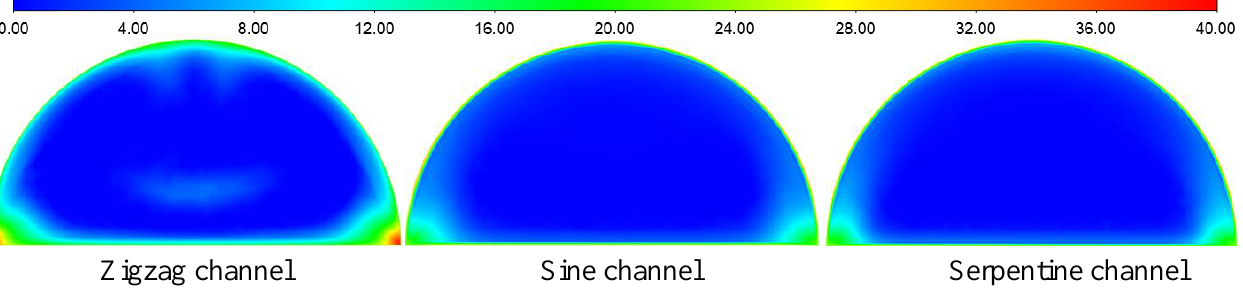
Figure 23. The distribution of local heat transfer entropy generation rate ( Re in = 2500, A = tan57.5° , q = 1 kW/m 2 , and 29% Xe; cross-section ID_3 in Figure 17).